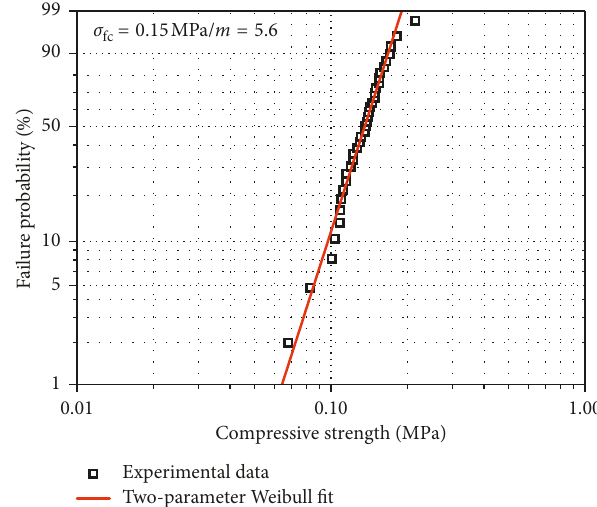
Figure 7: Compressive strength data of 20 ppi ZnO ceramic foams ( □ ) and the corresponding fit with the two-parameter Weibull function (red